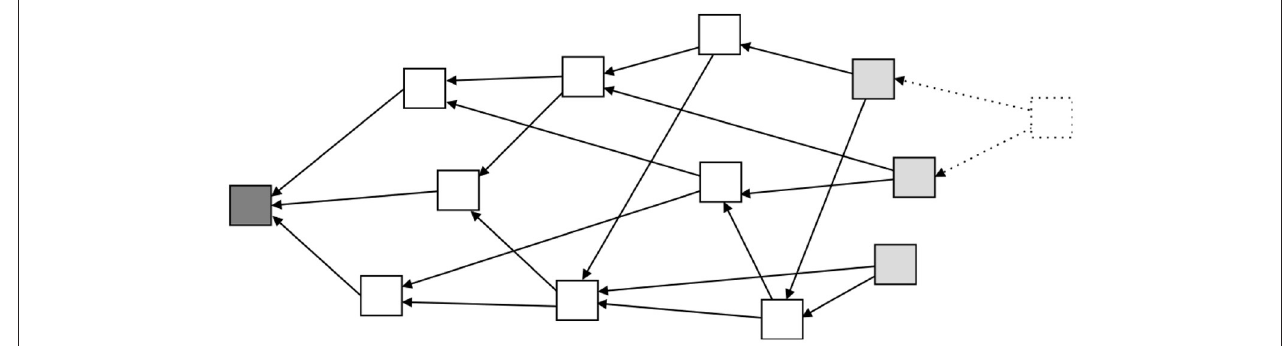
FIGURE 3 | A diagram for illustrating an example of Tangle architecture. Note that, opposite to Figure 1 , here one block can have more than one children. Following the same color scheme as before, dark gray represents the genesis block, white represents regular blocks, and light gray represents tip blocks. In this type of architecture, the new blocks need to attach themselves to at least two other tip blocks. This process is illustrated by the dashed line